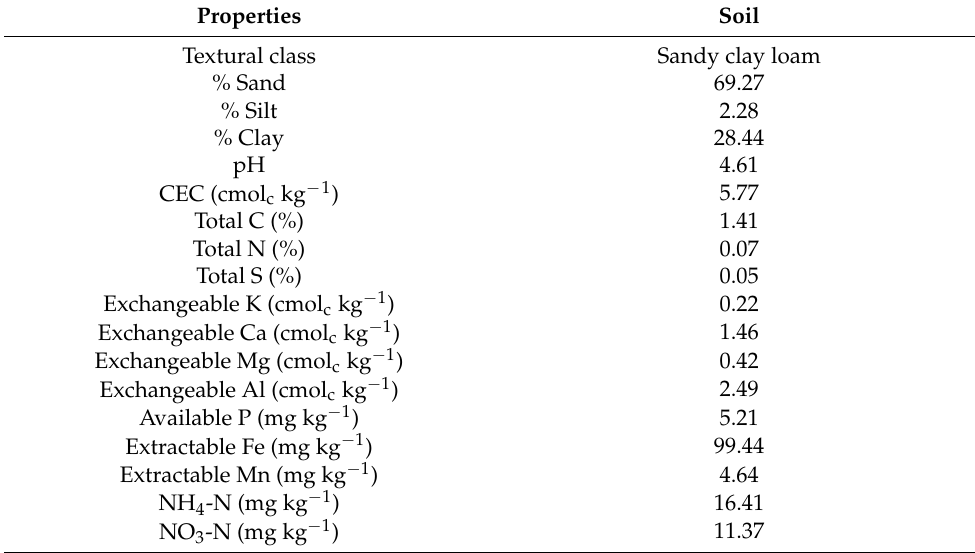
Table 1. Selected physico-chemical properties of initial soil.